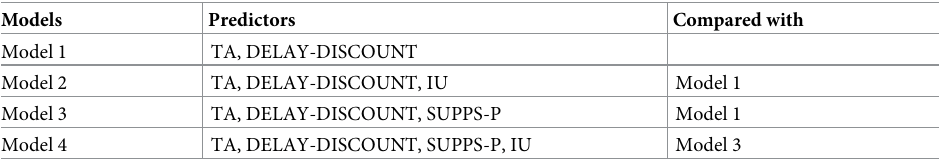
Table 1. Summary of the regression